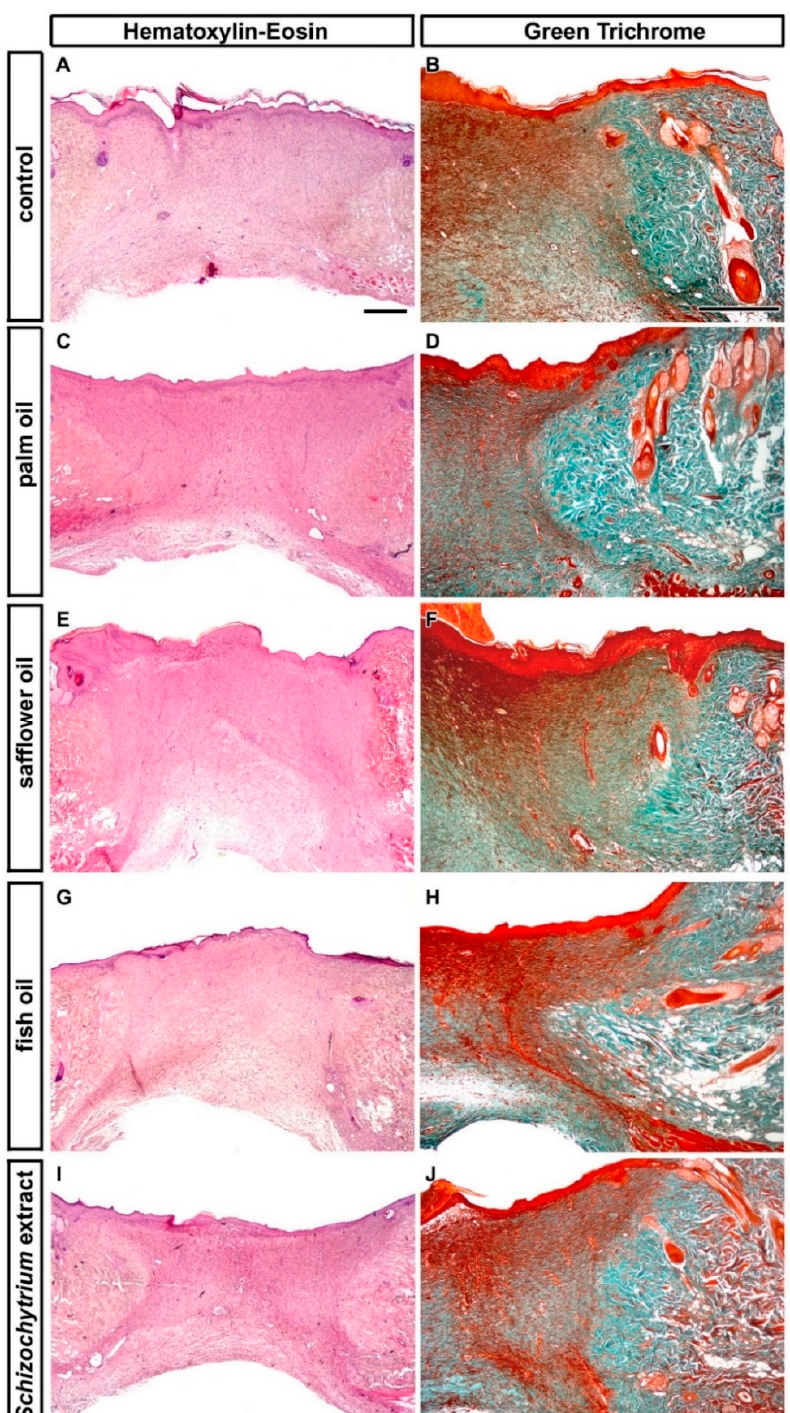
Figure 3. Microscopic structure of wound area. Transversal sections through the wound at 12 days post-excision of rats fed 52 days a standard diet alone (control) ( A , B ), or a standard diet enriched with palm oil ( C , D ), safflower oil ( E , F ), fish oil ( G , H ), and Schizochytrium extract ( I , J ), respectively, stained by Hematoxylin-Eosin (first column) and Masson’s Green Trichrome (second column). Scale bar = 100 µm.